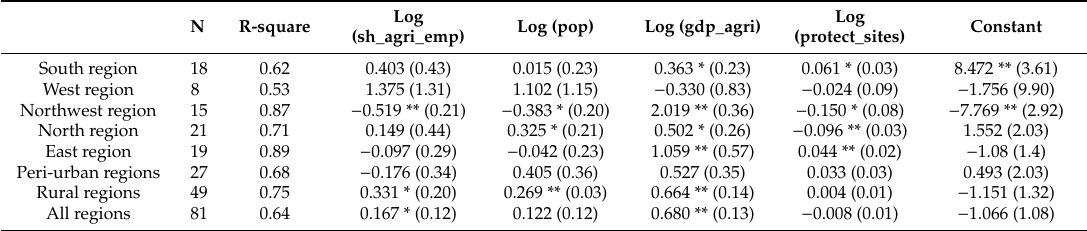
Table 10. Results of the regression analysis explaining development of agricultural land for di ff erent